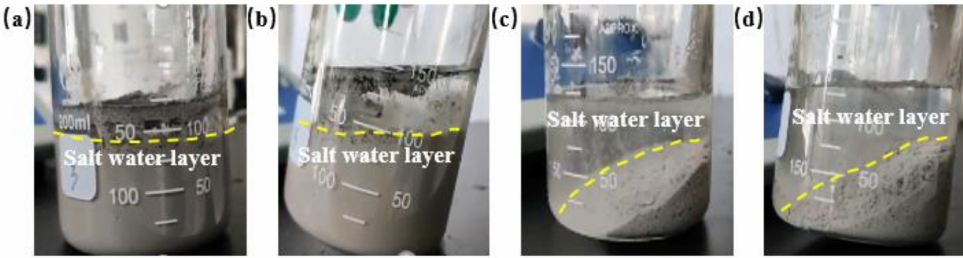
Figure 2. Anti-dilution performance diagram of salt water: ( a ) 1/3 volume salt water; ( b ) 2/3 volume salt water; ( c ) 1/3 volume gel; ( d ) 2/3 volume